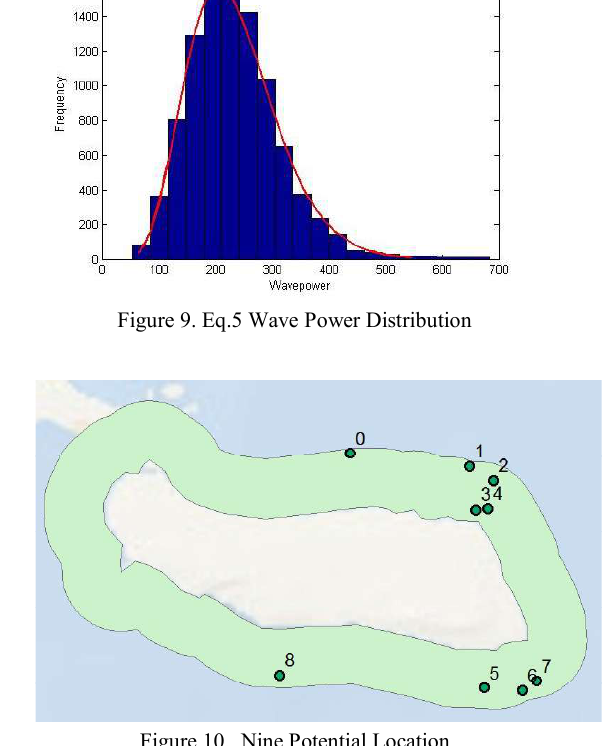
Figure 10. Nine Potential